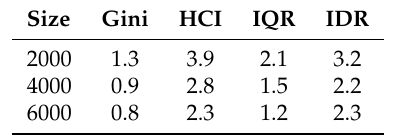
Table 6. Relative standard deviation (%) of each parameter applying PSA with the proportional reference sample. Size Gini HCI IQR